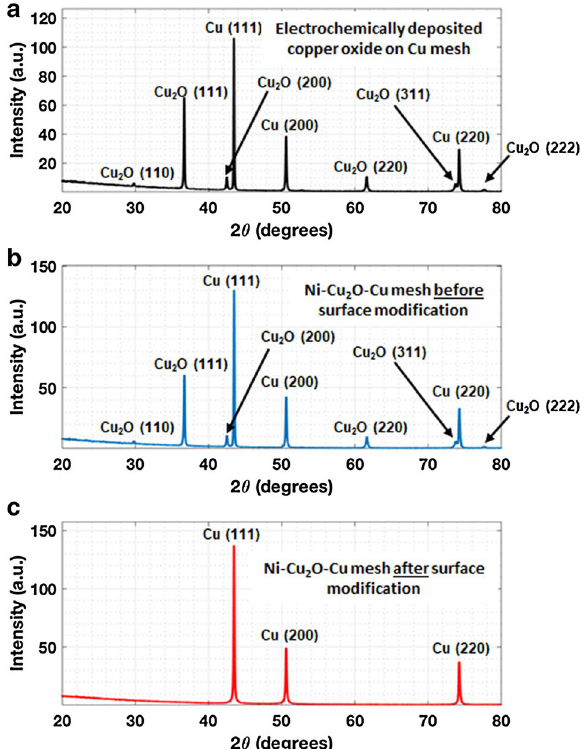
Figure 4. X-ray diffraction (XRD) spectra of electrode surface at various stages of the fabrication process. (a) XRD spectra of electrochemically deposited copper oxide on the Cu mesh. (b) XRD spectra of the nanostructured heterolayer electrode before photoelectrochemical surface modification. (c) XRD spectra of the nanostructured heterolayer cathode after photoelectrochemical surface modification. Note the disappearance of the oxide peaks, consistent with EDS and XPS results. The (111), (200), and (220) peaks of Cu at 2θ = 43.44°, 2θ = 50.5°, and 2θ = 74.2°, respectively, are evident in all three spectra 36,42–44